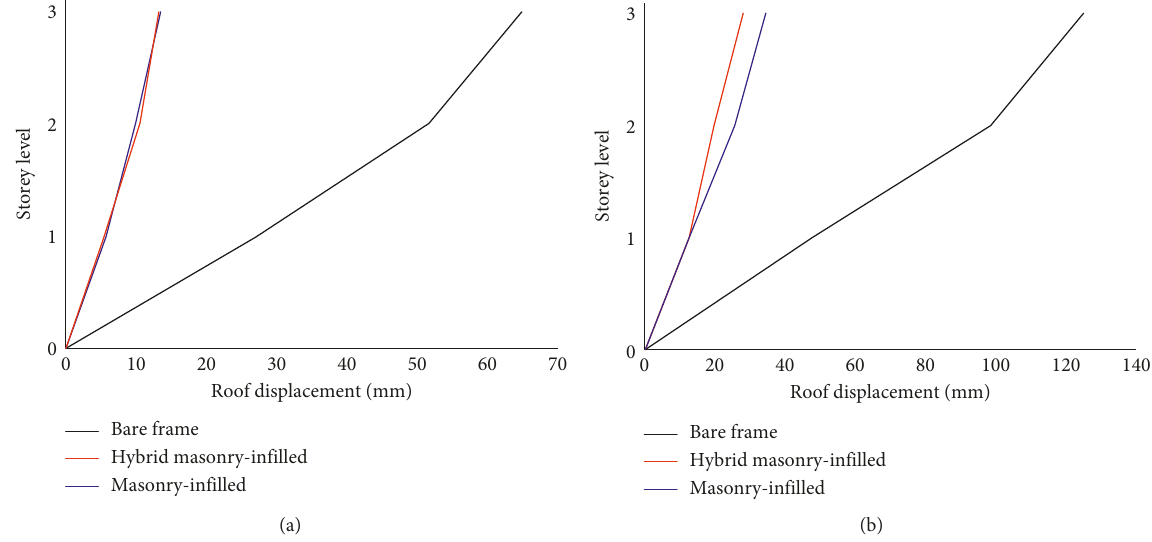
Figure 11: Maximum lateral displacement envelope of test models for increasing input excitation. Displacements were converted to the corresponding prototype values. (a) Lateral displacement under NR1. (b) Lateral displacement under NR2.